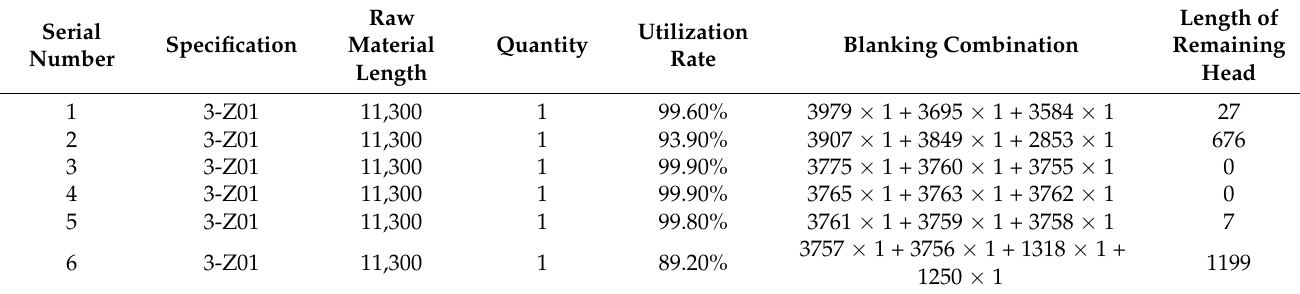
Table 6. 3-Z01 keel blanking combination.